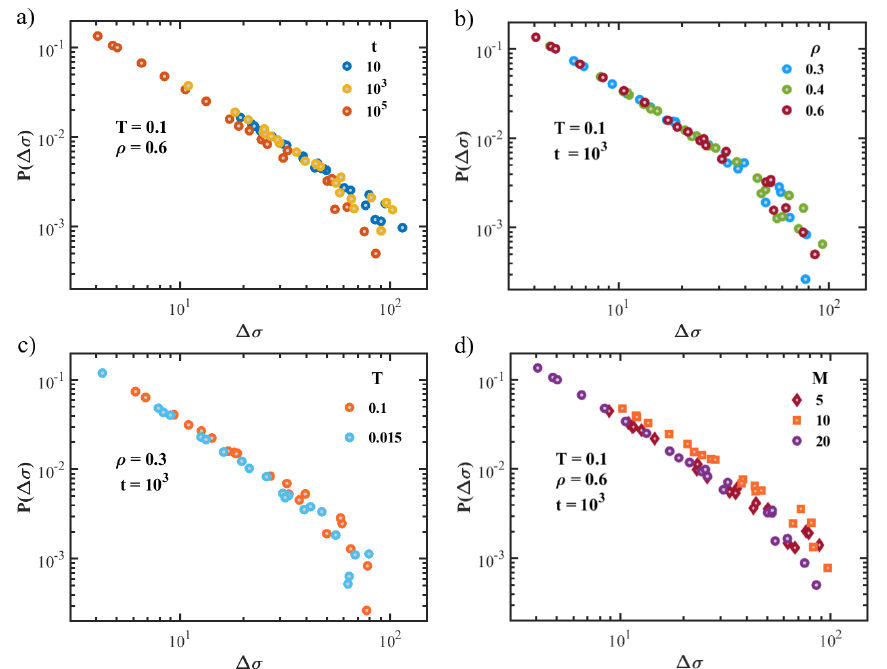
Figure 5. Distribution P ( ∆ σ ) of the stress drops in the plastic regime of mechanical response, exploring different combinations of state parameters. Specifically, while keeping fixed all the other parameters, we changed the age (panel a ), the density (panel b ), the quench temperature (panel c ) and the chain length (panel d